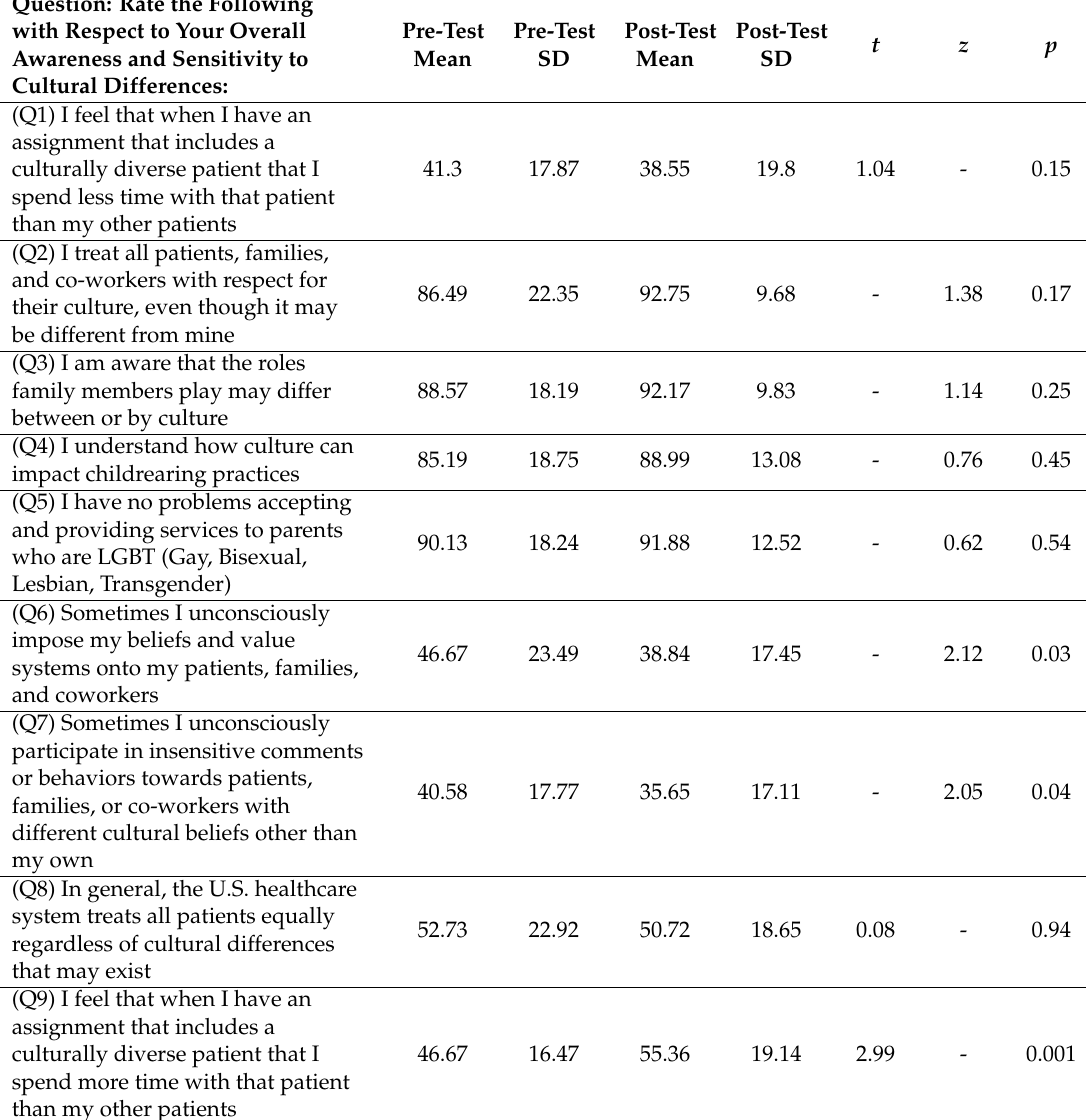
Table 2. Providers’ cultural awareness and sensitivity survey results a,b